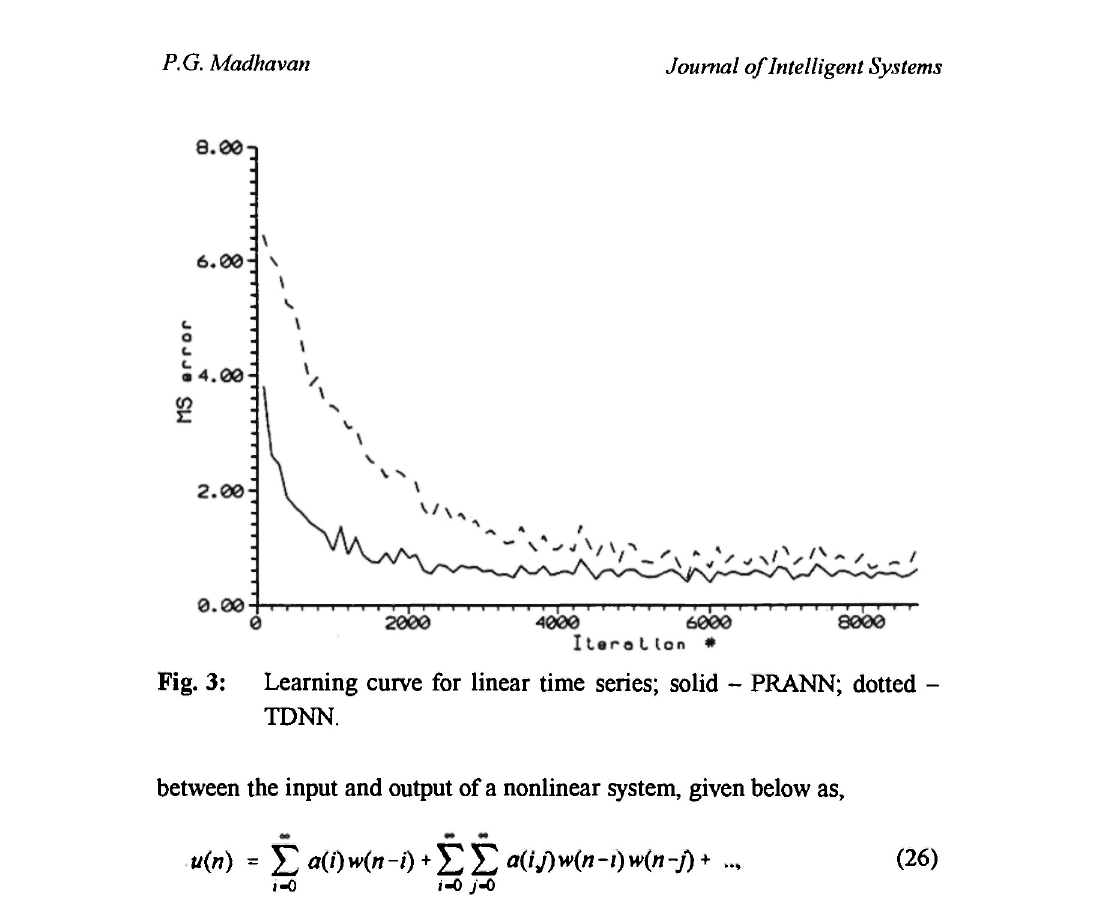
Fig. 3: Learning curve for linear time series; solid - PRANN; dotted -